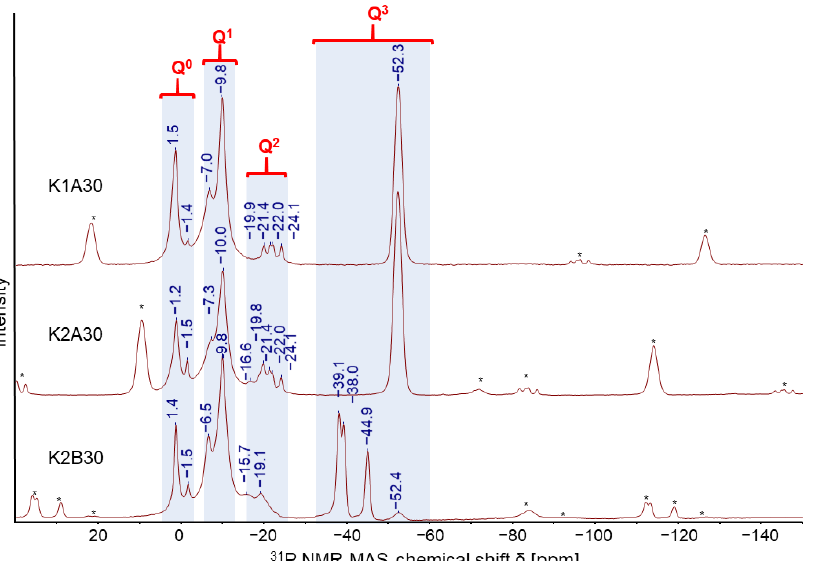
Figure 10. 31 P MAS NMR spectra of two potassium water glasses with different alkali modulus K1 = 3.09, K2 = 3.53 with 30wt% aluminum tetrametaphosphate KXA30 and aluminum hexametaphosphate K2B30 [22].